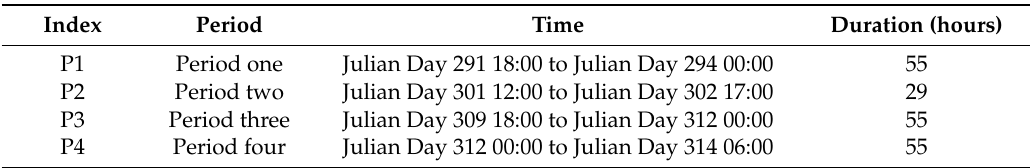
Table 1. High resolution forecast offshore winds.